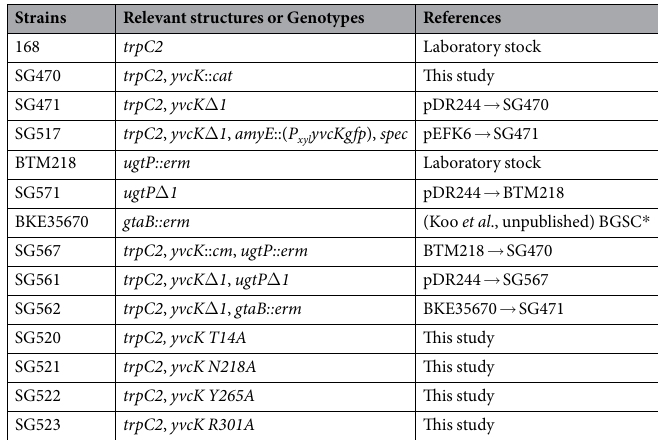
Table 2. B. subtilis strains used in this study.